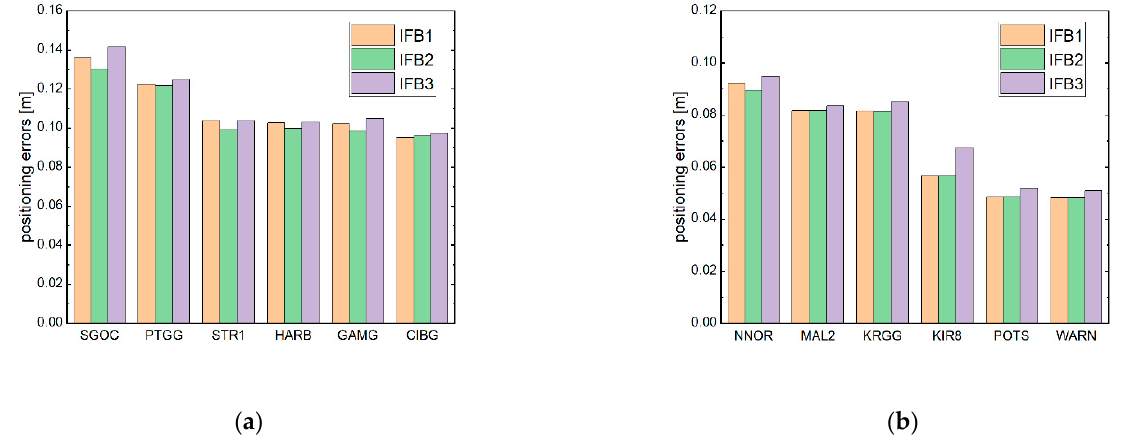
Figure 6. The 3D positioning errors of UC-PPP for station KRGG on DOY 001, 2022. The E, N, and U represent the errors in positioning in the east, west, and south up directions of station KRGG, respectively. Subfigures ( a , b ) represent global positioning error and local positioning error.